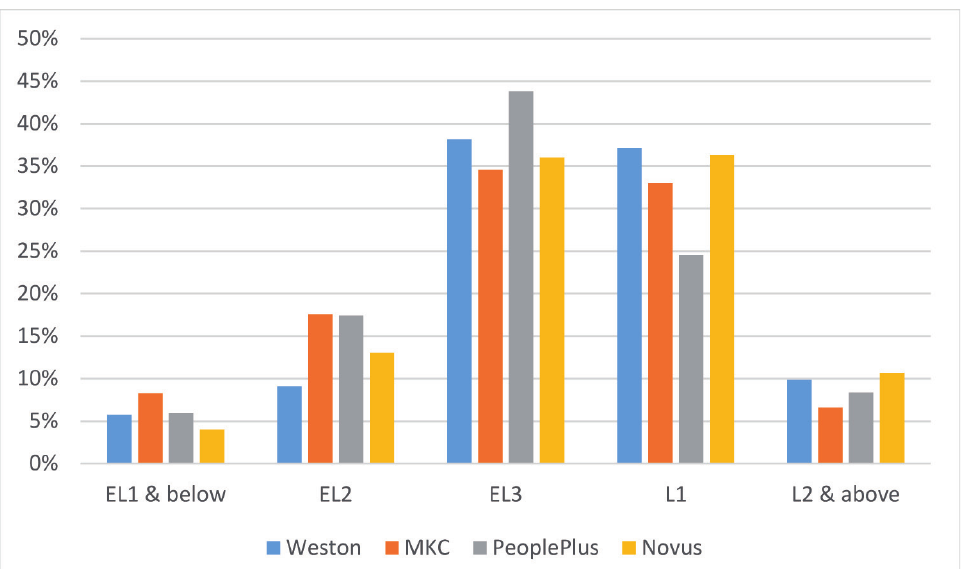
Figure 10: Prisoners’numeracylevelsbyprovider Thisinconsistencycouldbecausedbytheprovidershavingadifferentrangeofprisonstowork with,oritcouldreflectdifferentapproachestoconductingtheassessments.Furtherresearch